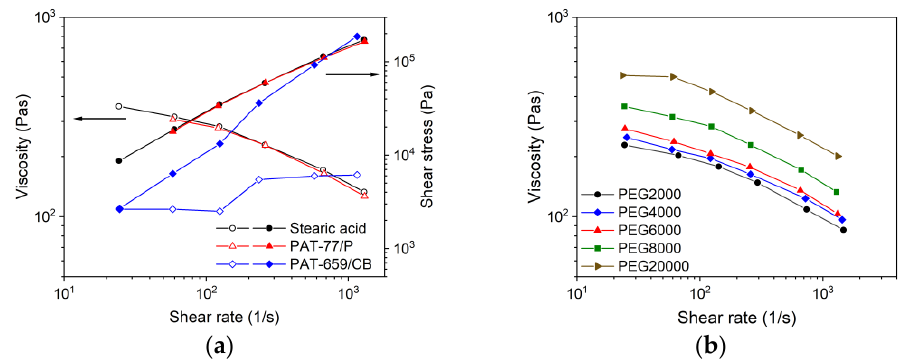
Figure 6. ( a ) Shear rate dependent melt viscosity as well as shear stress at 160 °C of PEG8000/PVB- based binder at a solid load of 60 vol% and different surfactants; ( b ) variation of the PEGs’ average molecular weight with 5 wt% SA as surfactant.